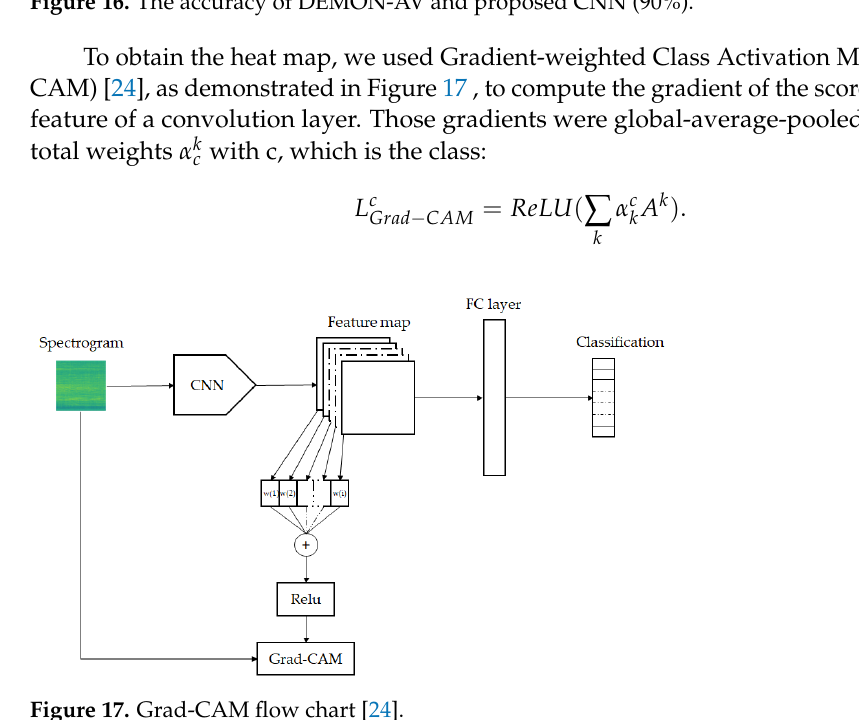
Figure 16. The accuracy of DEMON-AV and proposed CNN (90%).